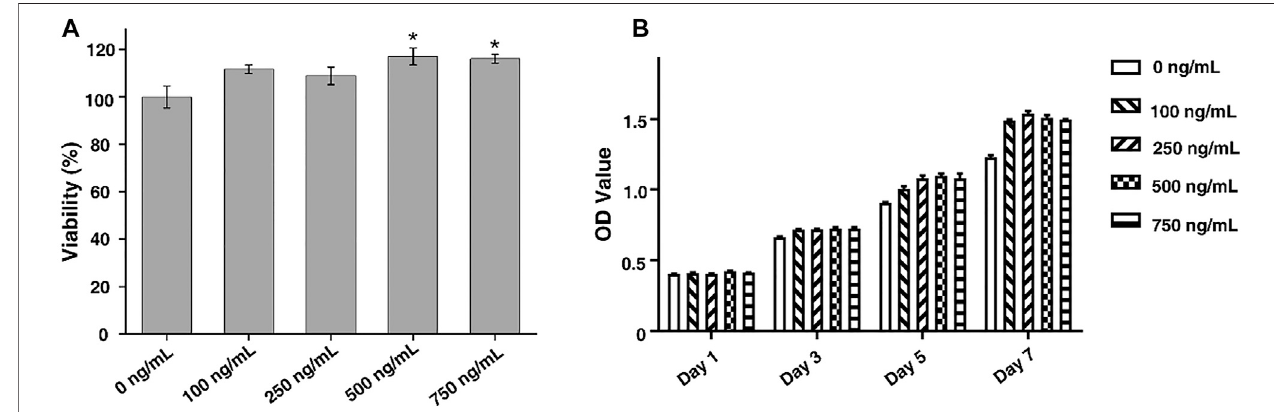
FIGURE 3 | (A) Cytotoxicity of FGF-2 to ADSCs. (B) Cell proliferation of ADSCs in culture medium with different concentrations of FGF-2 (1, 3, 5, and 7 days). The statistic comparison was made between a control group (0 ng/ml) and each FGF-2 group (100 ng/ml, 250 ng/ml, 500 ng/ml, and 750 ng/ml). p value of < 0.05 was considered signi fi cant.